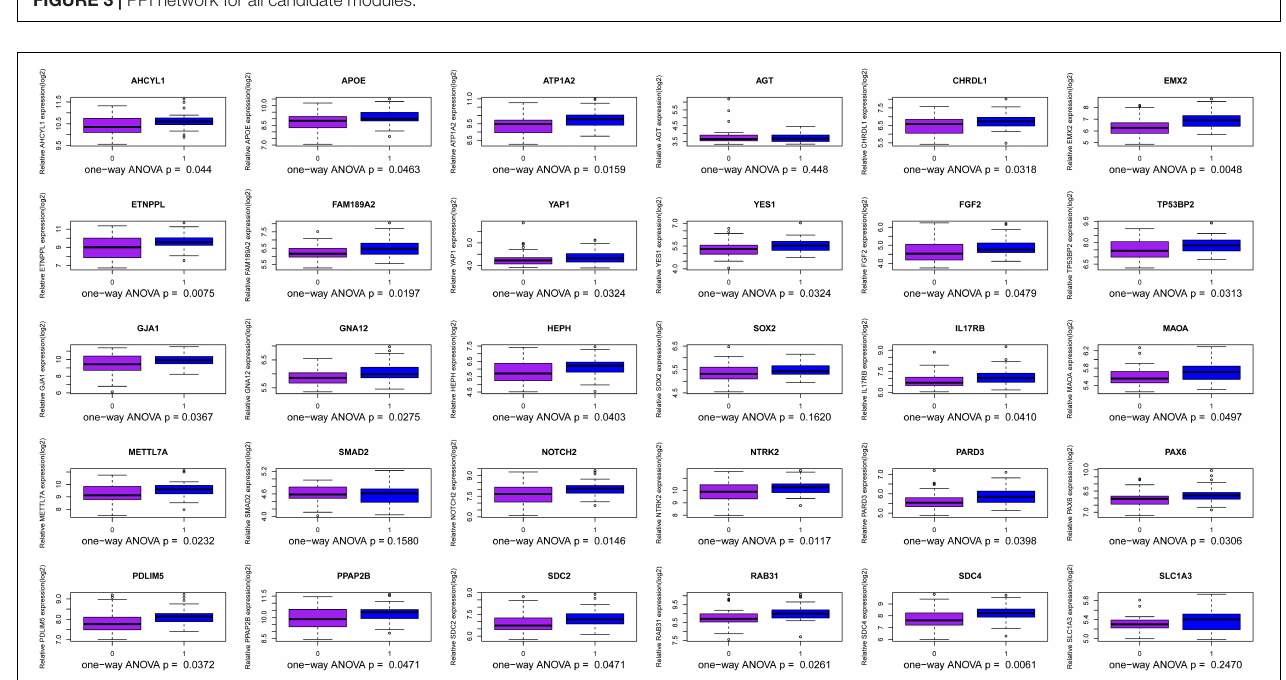
FIGURE 4 | Boxplot for identification of hub genes in the three